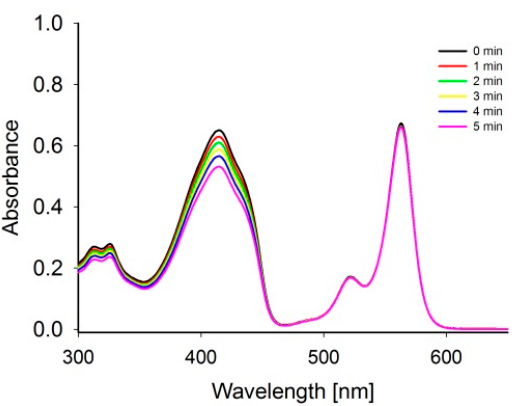
Figure 2. Spectra changes in the RB and DPBF mixture in DMF under sonication with 1 MHz, 3 W and duty cycle 40% during the experiment. Table 1. Kinetic parameters of DPBF and TTF decomposition upon sonication in DMF solution alone and in the presence of Ce6 and RB. The stability parameters of RB and Ce6 upon sonication were also